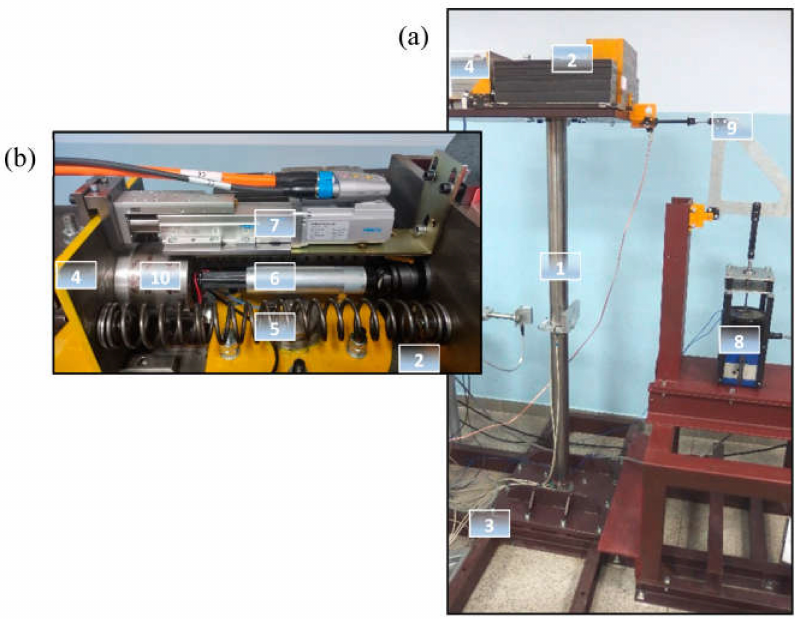
Figure 4. The laboratory test rig: ( a ) a general view, ( b ) the H-MR-TVA. The data acquisition and control system used a laser sensor for the nacelle-unit absolute displacement (i.e., the tower tip deflection) x 1 measurement, a laser vibrometer for the H-MR-TVA mass absolute displacement x 2 measurement, the MR damper force sensor (no. 10), the shaker force sensor, the MR damper coil current Hall sensor, power supply